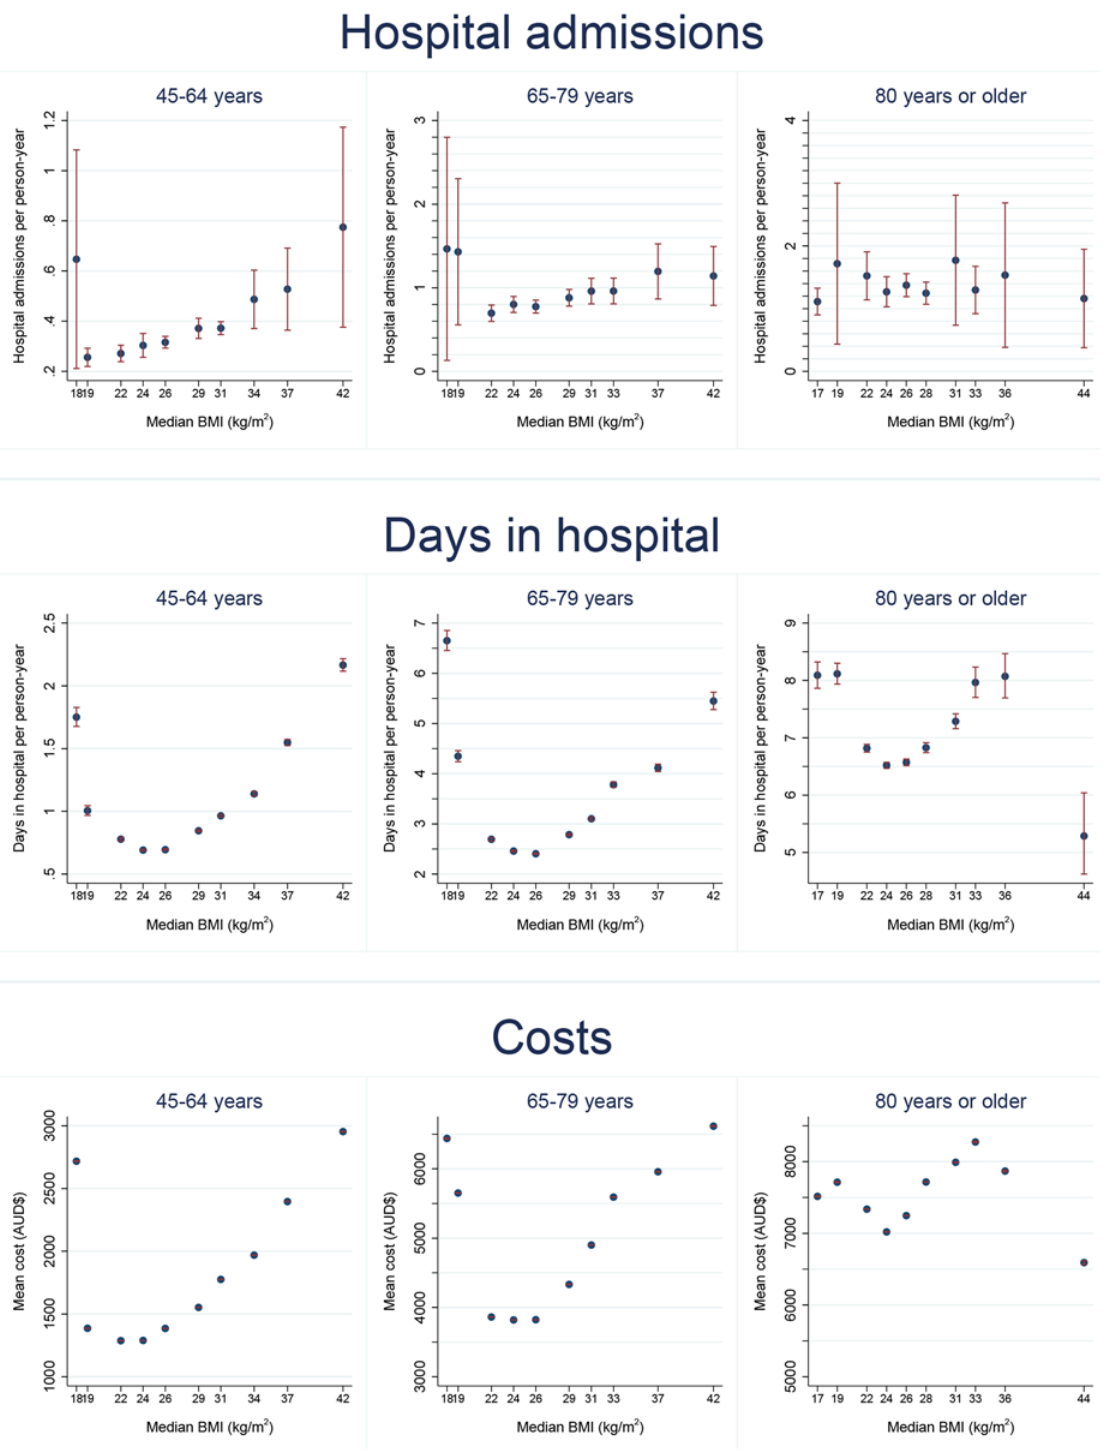
Fig 1. Age-standardised hospital admissions, days in hospital and costs per person-year (with 95% CIs) by body mass index (BMI), males. Notes. 1. Within each age group, rates are age-standardised to the 2006 NSW population (in 5 year age-groups) using the direct method.